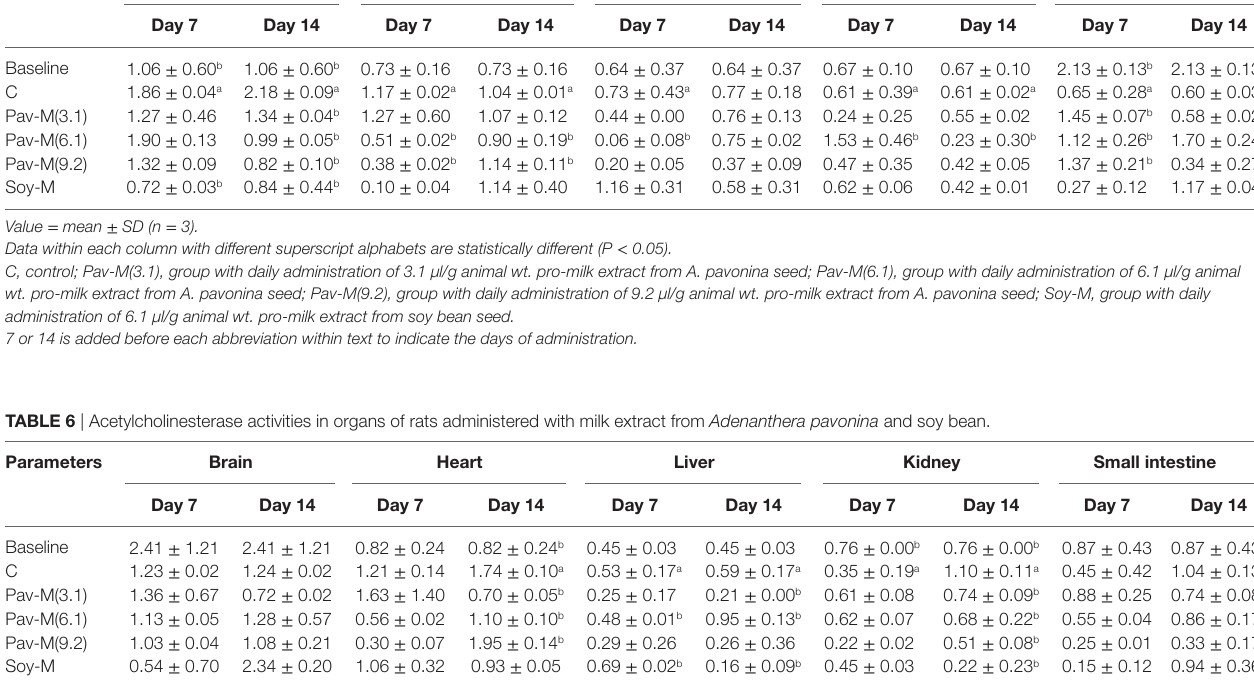
TaBle 5 | Cytochrome P450 activities in organs of rats administered with milk extract from Adenanthera pavonina and soy bean. Parameters